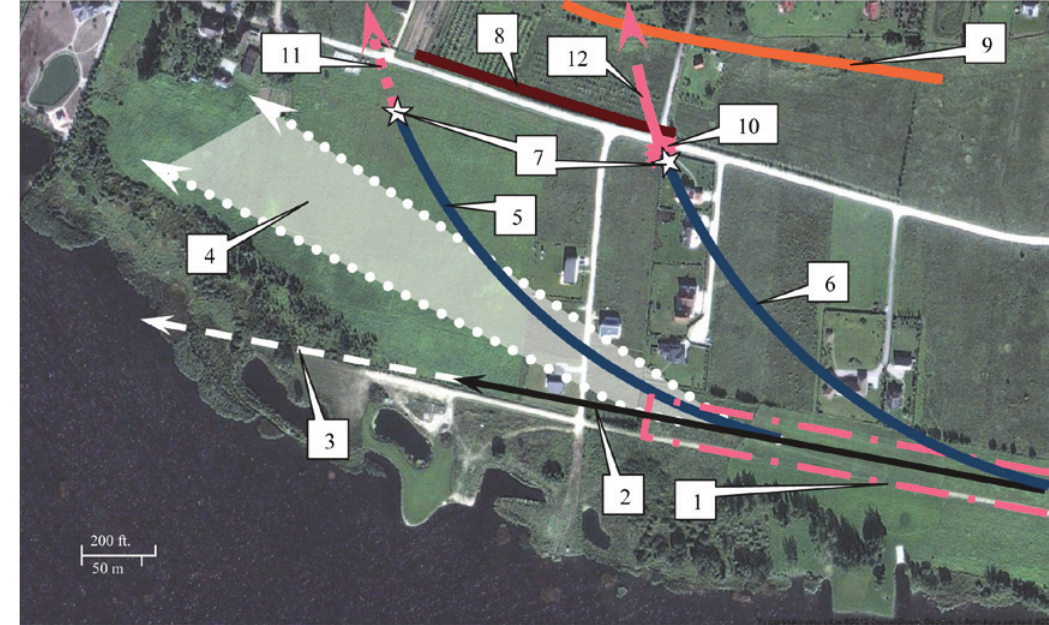
Fig. 2. Satellite photo of the Cessna 152 crash site with an explanation scheme for calculation option No 1: 1) take-off runway; 2) take-off heading; 3) direction of aircraft if the engine had shut down in flight and no additional manoeuvering had taken place (as per FM: flight manual); 4) allowable range of manoeuvering if the engine had shut down in flight (as per FM); 5) – 6) the possible range of trajectories for the plane; 7) the turning point for the aicraft at 45 degrees against the take-off line; 8) electrical power lines and fence; 9) place where terrain starts to rise; 10) the location of the crash; 11) – 12) it is not possible to continue the movement of aircraft in order to make a turn of 90 degrees because of